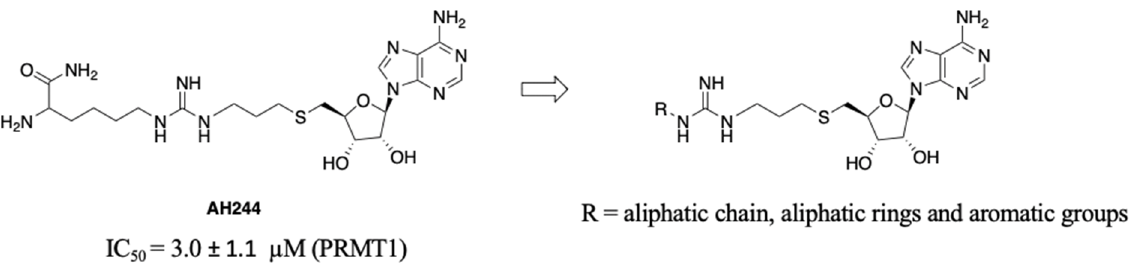
Figure 2. Design of pan-PRMT inhibitors.